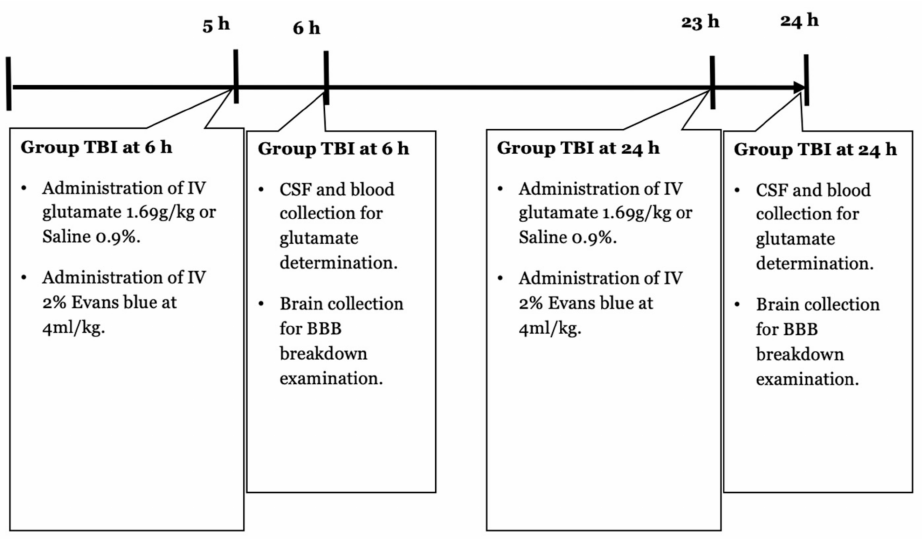
Figure 5. A timeline protocol for TBI-based BBB opening model. Intravenous